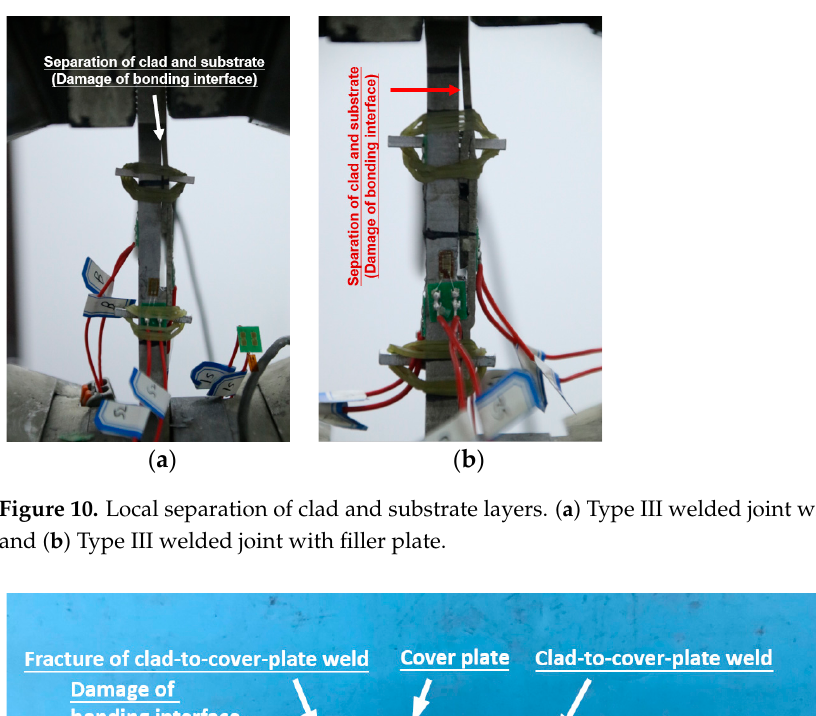
Figure 10. Local separation of clad and substrate layers. ( a ) Type III welded joint without filler plate and ( b ) Type III welded joint with filler plate.